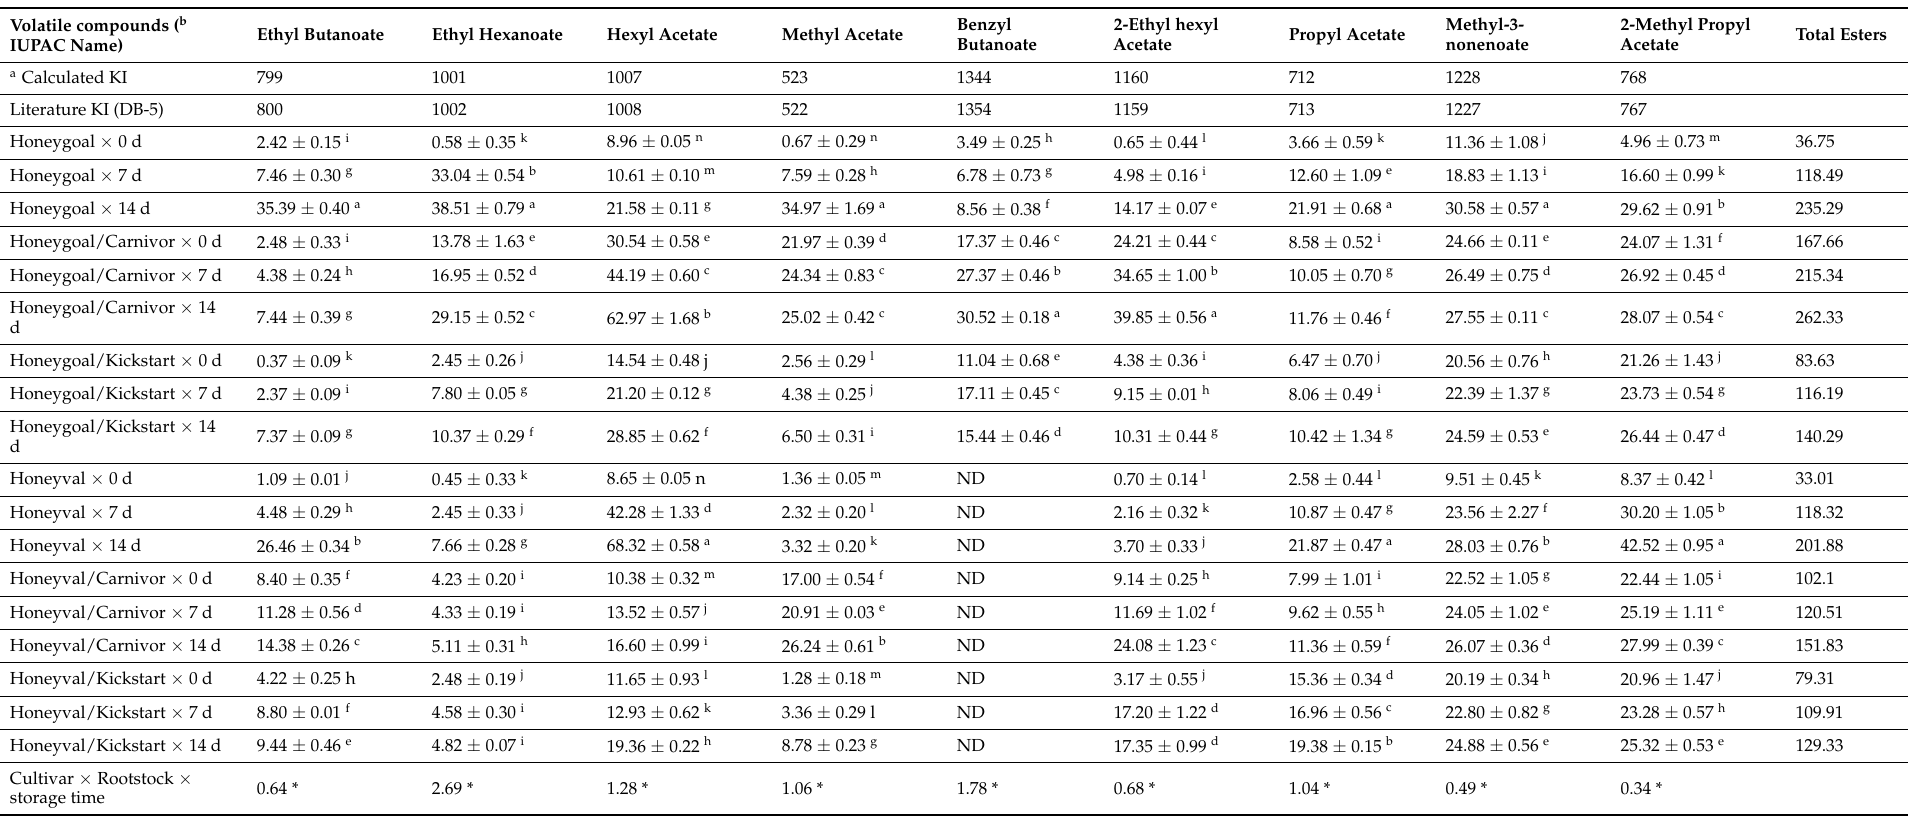
Table 3. Changes in volatile compounds (Esters) of honeydew melon cultivars influenced by grafting and postharvest storage ( µ